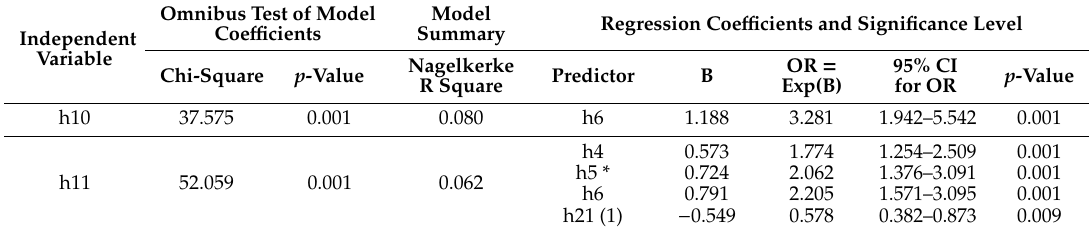
Table 8. Outputs of binomial logistic regression analysis (N =